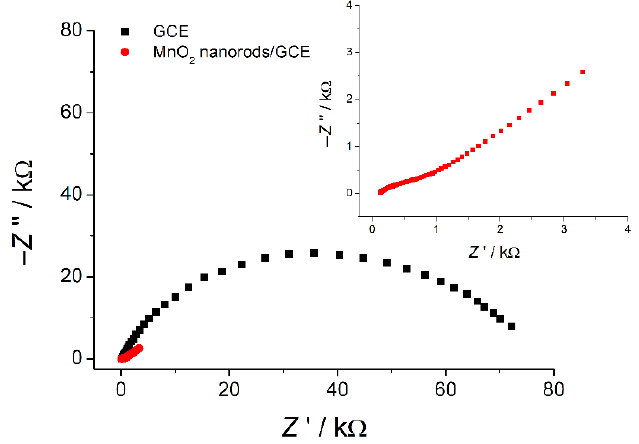
Figure 5. Nyquist plot for bare GCE and MnO 2 nanorods/GCE in the presence of 1.0 mM hexacy- anoferrate(II)/(III) ions in 0.1 M KCl. E = 0.23 V; frequency range = 10 kHz—0.04 Hz; amplitude = 5